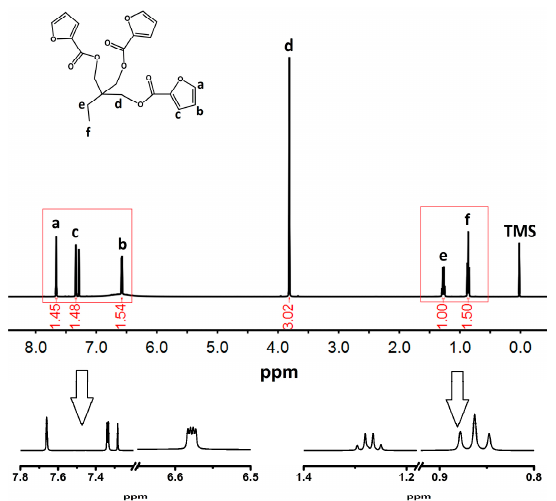
Figure 4. 1 H nuclear magnetic resonance (NMR) spectrum of TFP: δ = 7.66, 3H; δ = 7.32–7.34, 3H; δ = 6.57–6.59, 3H; δ = 3.81, 6H; δ = 1.25–1.30, 2H; δ = 0.85–0.88, 3H. FTIR on FTPB-PDMI film crack self-repairing progress. PDMI: N , N ′ -1,3-phenylenedimaleimide.